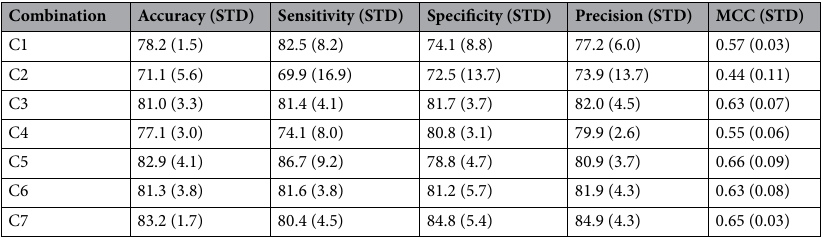
Table 6. Results achieved using fivefold cross validation for ACP-740 dataset (Complete sequences utilized instead of 15 N-terminus amino acids). The STD is also presented in the brackets for each measurement.